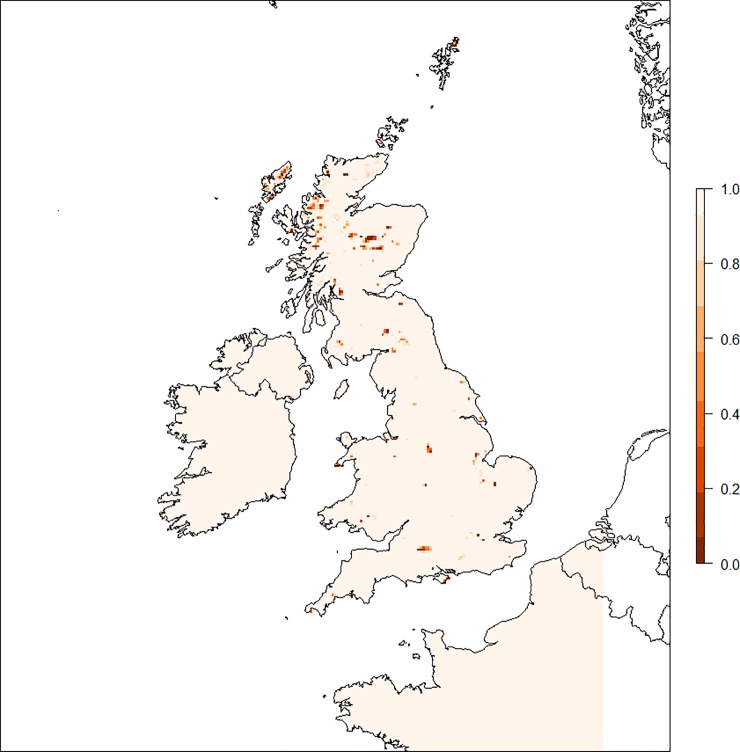
UK map detailing the results of the MESS analysis.The map shows the averaged result over all iterations of the model; a value close to 1 (lighter) indicates the region is described well by the training data, while a value close to zero (darker) indicates it is not.